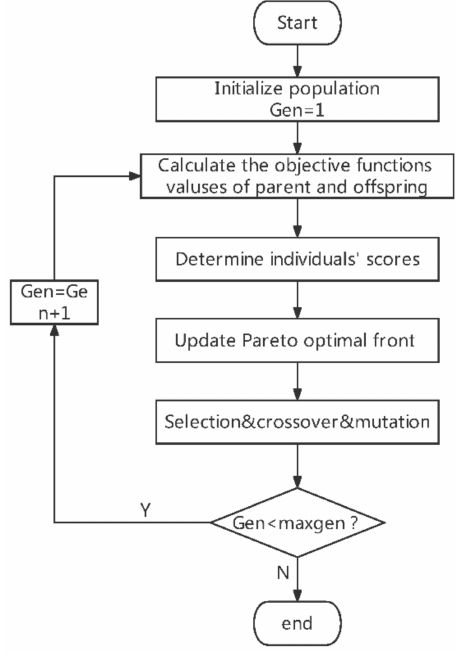
Figure 21. The optimization process of NSGA-II.